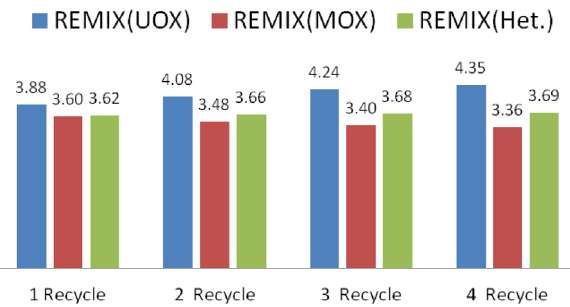
Fig. 5. Integral 235 U content for the core fuel loading,